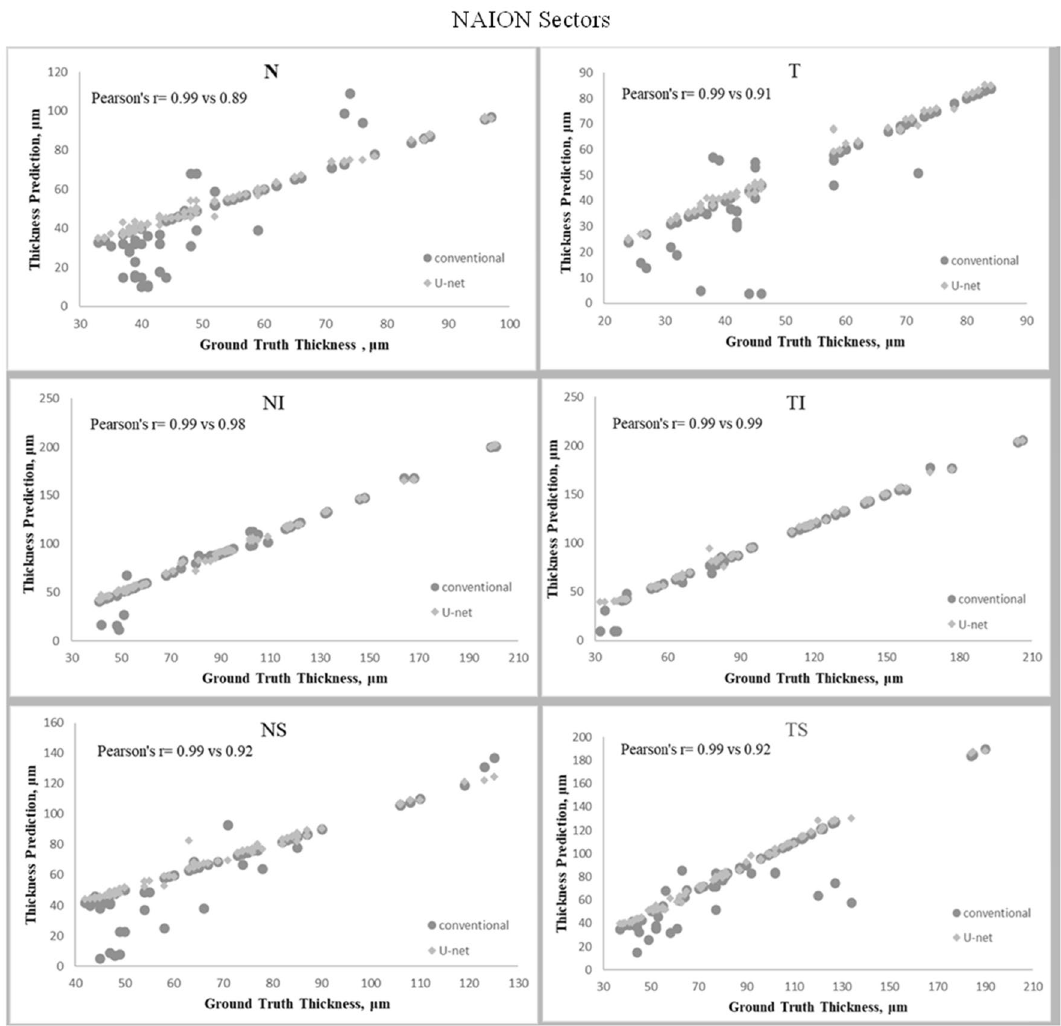
Figure 2. Line graphs showing correlation between each sector retinal nerve fiber layer (RNFL) thickness estimated by neural network and ground-truth in anterior ischemic optic neuropathy (AION) group. ( A ) Sector nasal (N), ( B ) sector temporal (T), ( C ) sector nasal inferior (NI), ( D ) sector temporal inferior (TI), ( E ) sector nasal superior (NS), ( F ) sector temporal superior